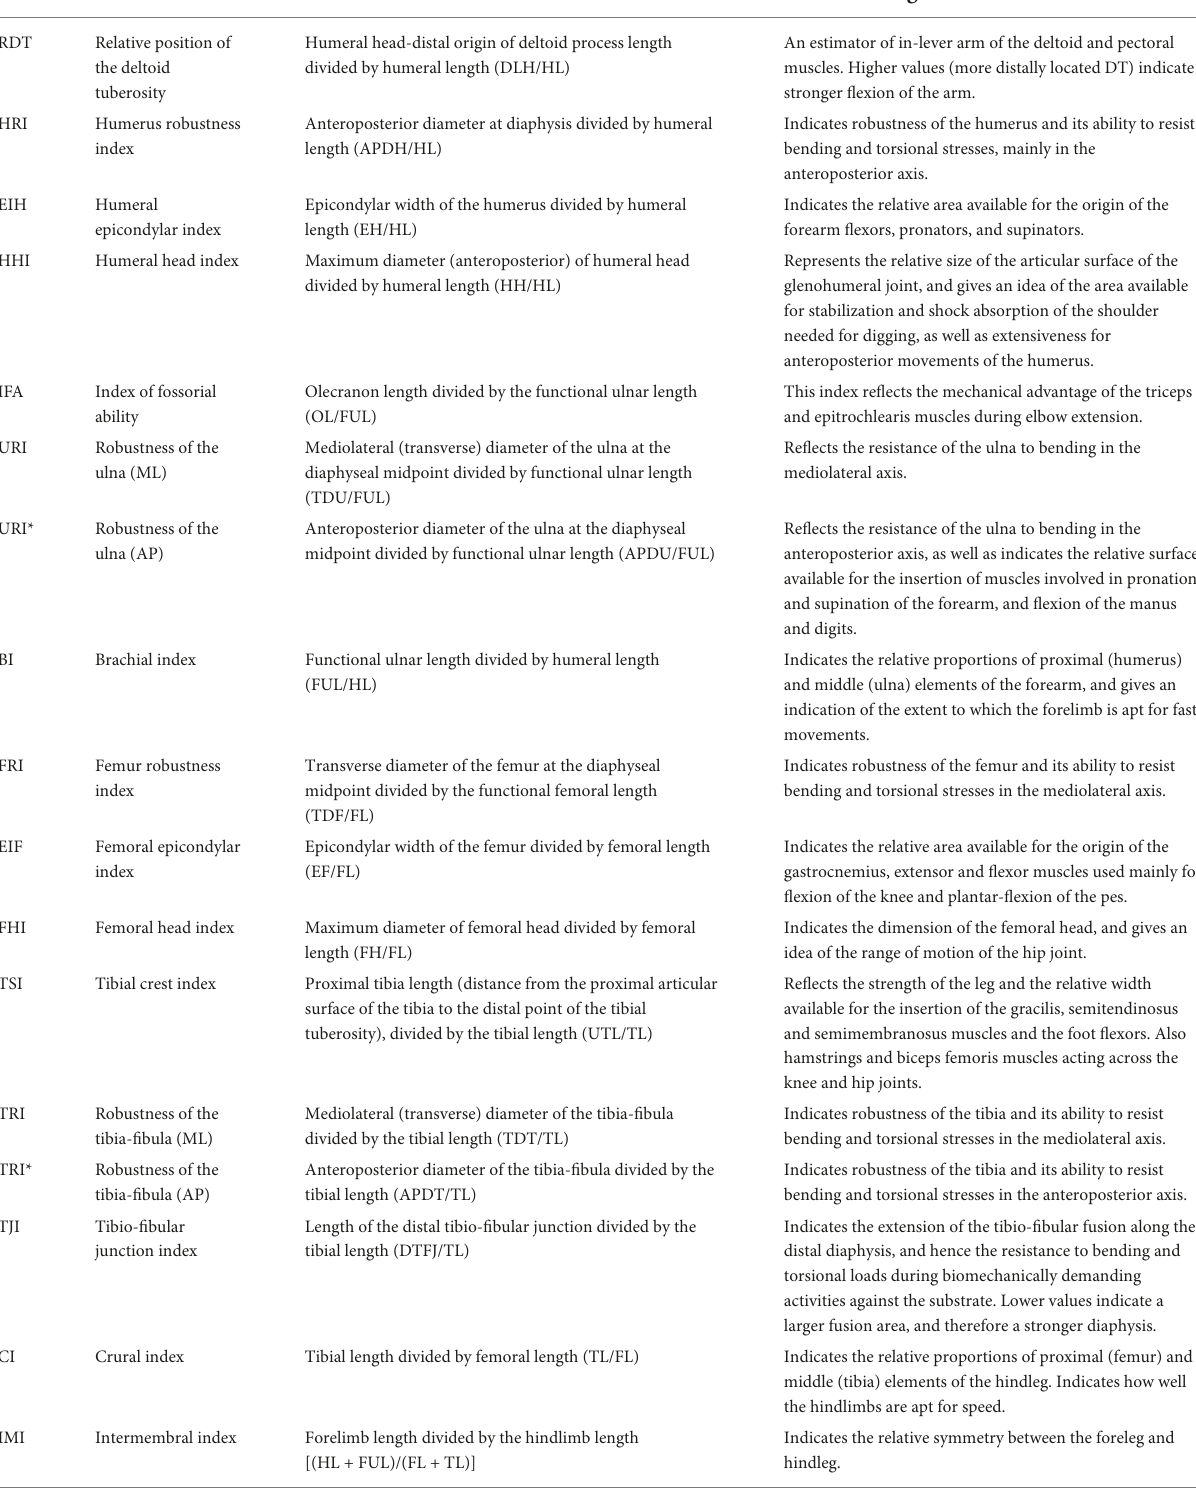
TABLE 2 Morpho-functional indices, calculation, and functional